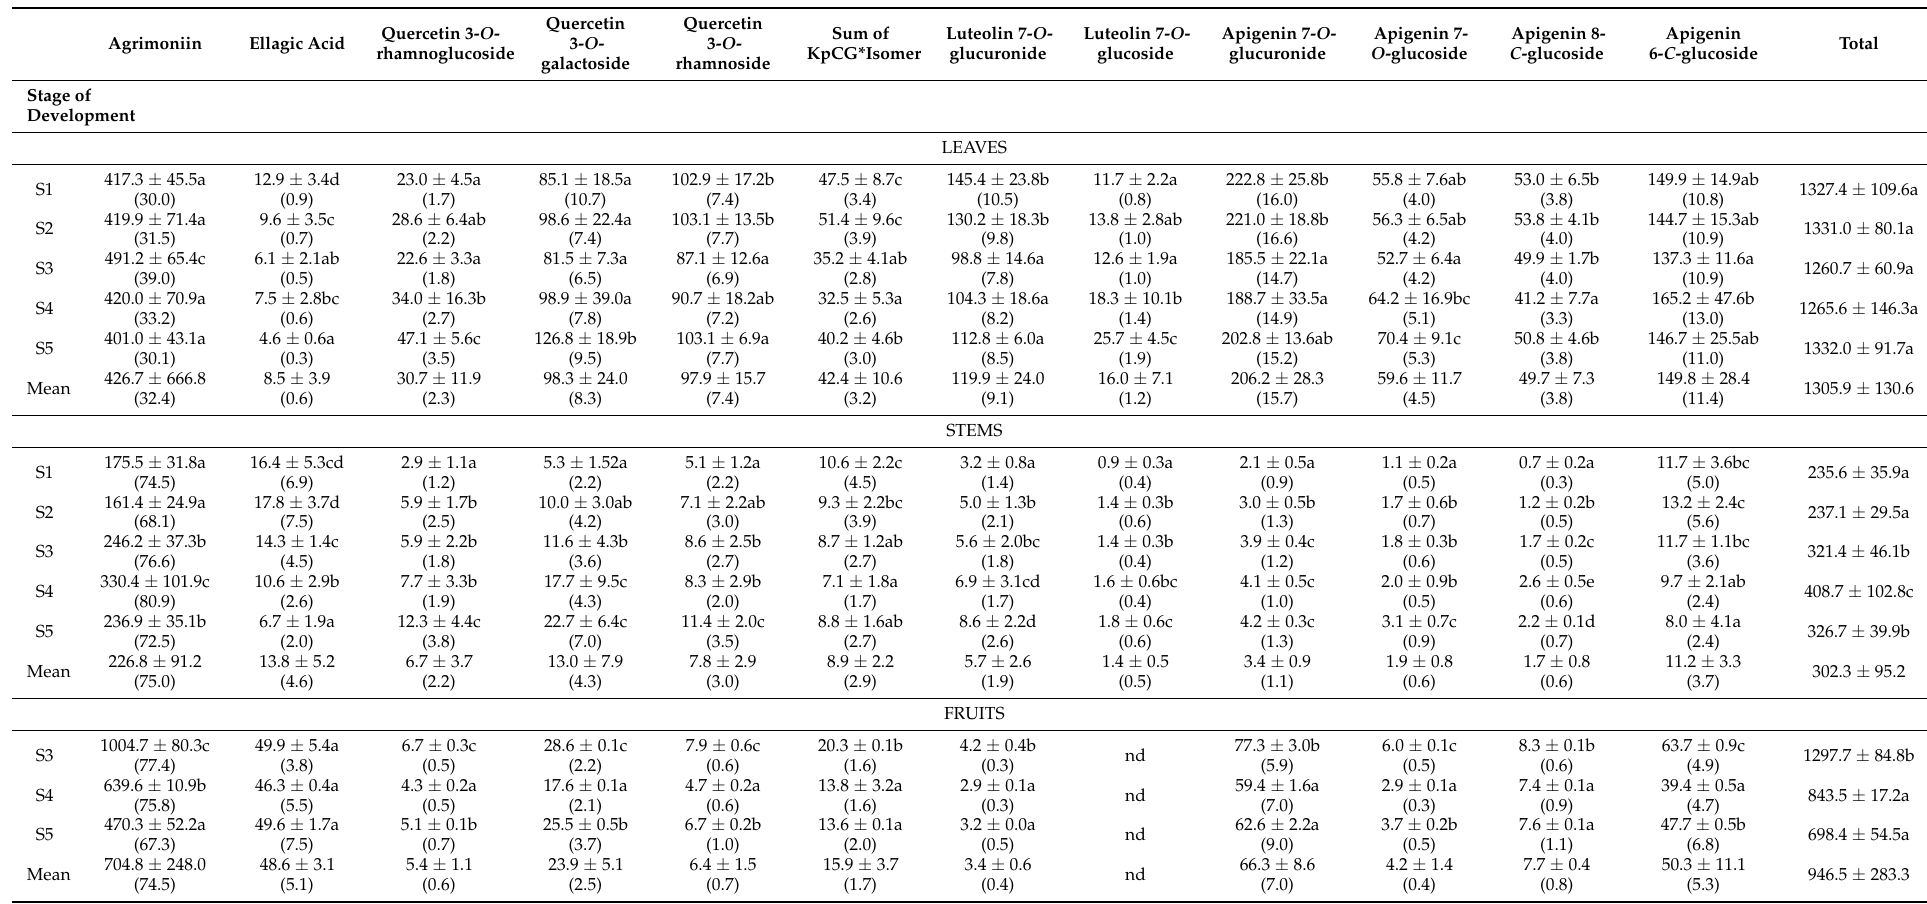
Table 3. The content of polyphenols in the aerial parts (leaves, stems, fruits, seeds, and hypanthia) of A. eupatoria at the main stages of plant development, expressed in mg/100 g of dry weight (DW) * and, in brackets, the percentage of each polyphenol related to the total polyphenol